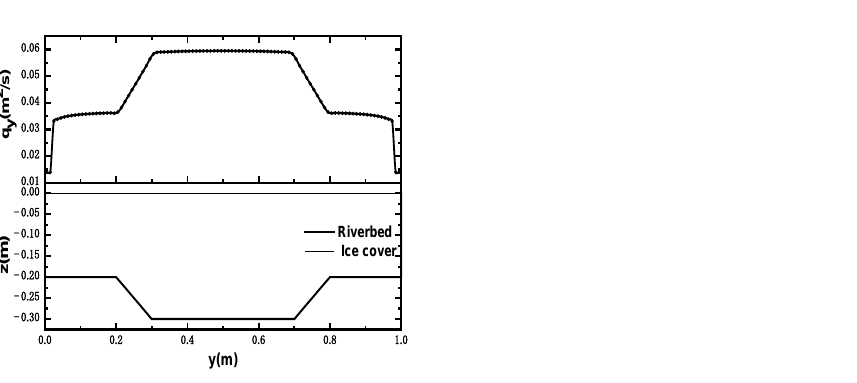
Figure 9. Section topography showing ice cover and riverbed distribution, and cross-sectional relative-unit discharge in a trapezoidal compound section.